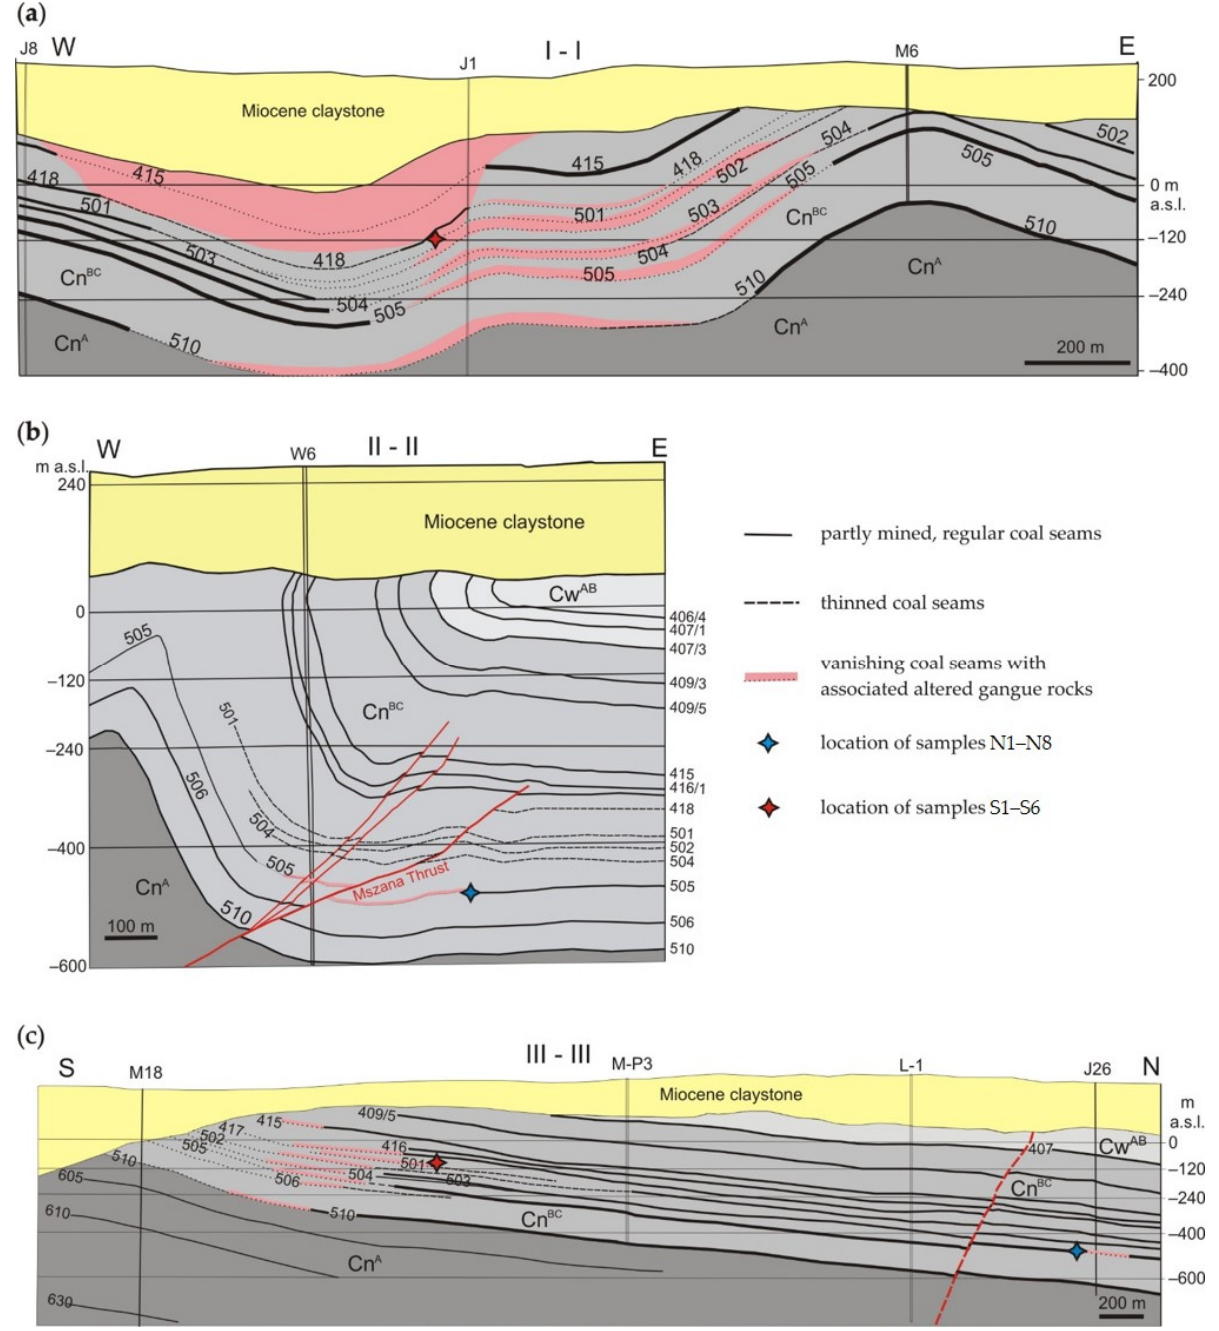
Figure 3. Cross-sections showing simplified geological settings in different areas of the Jas-Mos mining area, a part of the operating Jastrz ę bie-Bzie Coal Mine, with sample collecting locations (based on geological documentation of Jastrz ę bie-Bzie Coal Mine, simplified). ( a ) W–E southern cross-section I-I and location of samples S1–6 in south corridor II below coal seam 418; ( b ) W–E northern cross-section II-II with location of samples N1–8 collected from the outcrop of 505 seam in testing gallery 47, where the seam thins from 3.2 m to 0.4 m, at the distance of 30 m; ( c ) parallel N–S cross-section III-III, showing the position of samples N1–8 and S1–6.